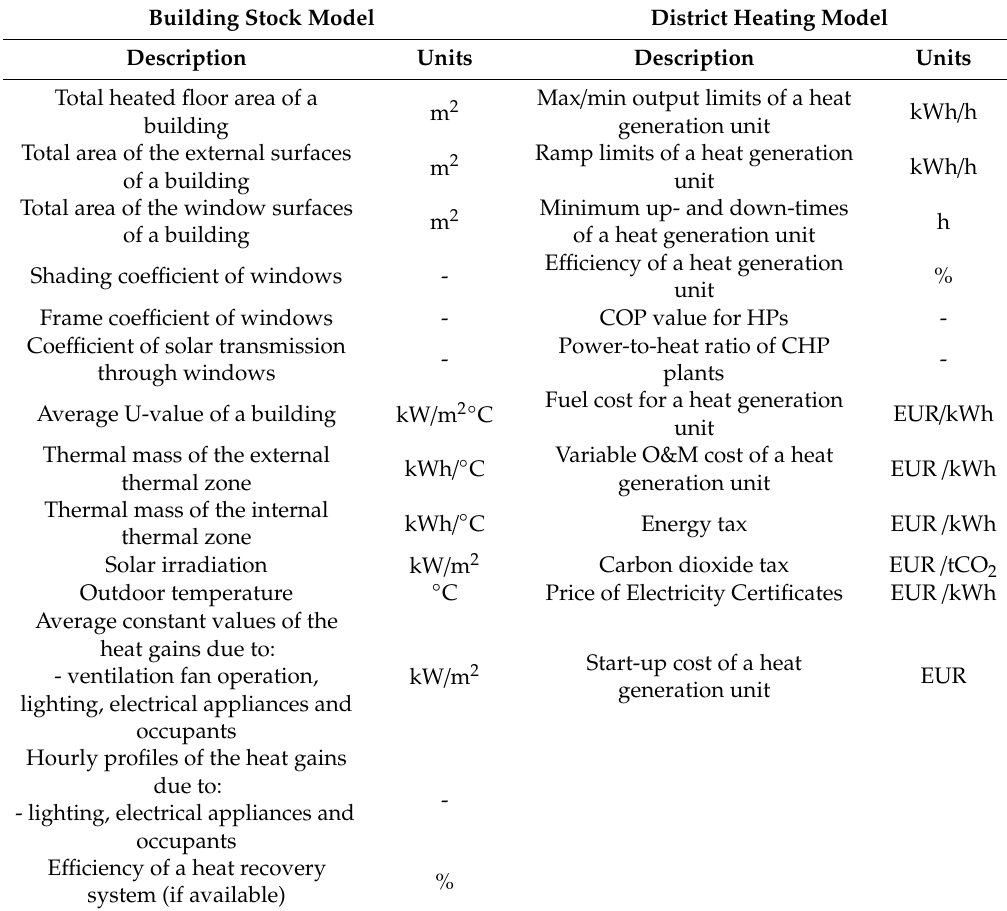
Table 1. The Energy Balance Unit Commitment (EBUC) model input parameters used to characterize the investigated building stock and the investigated district heating system of